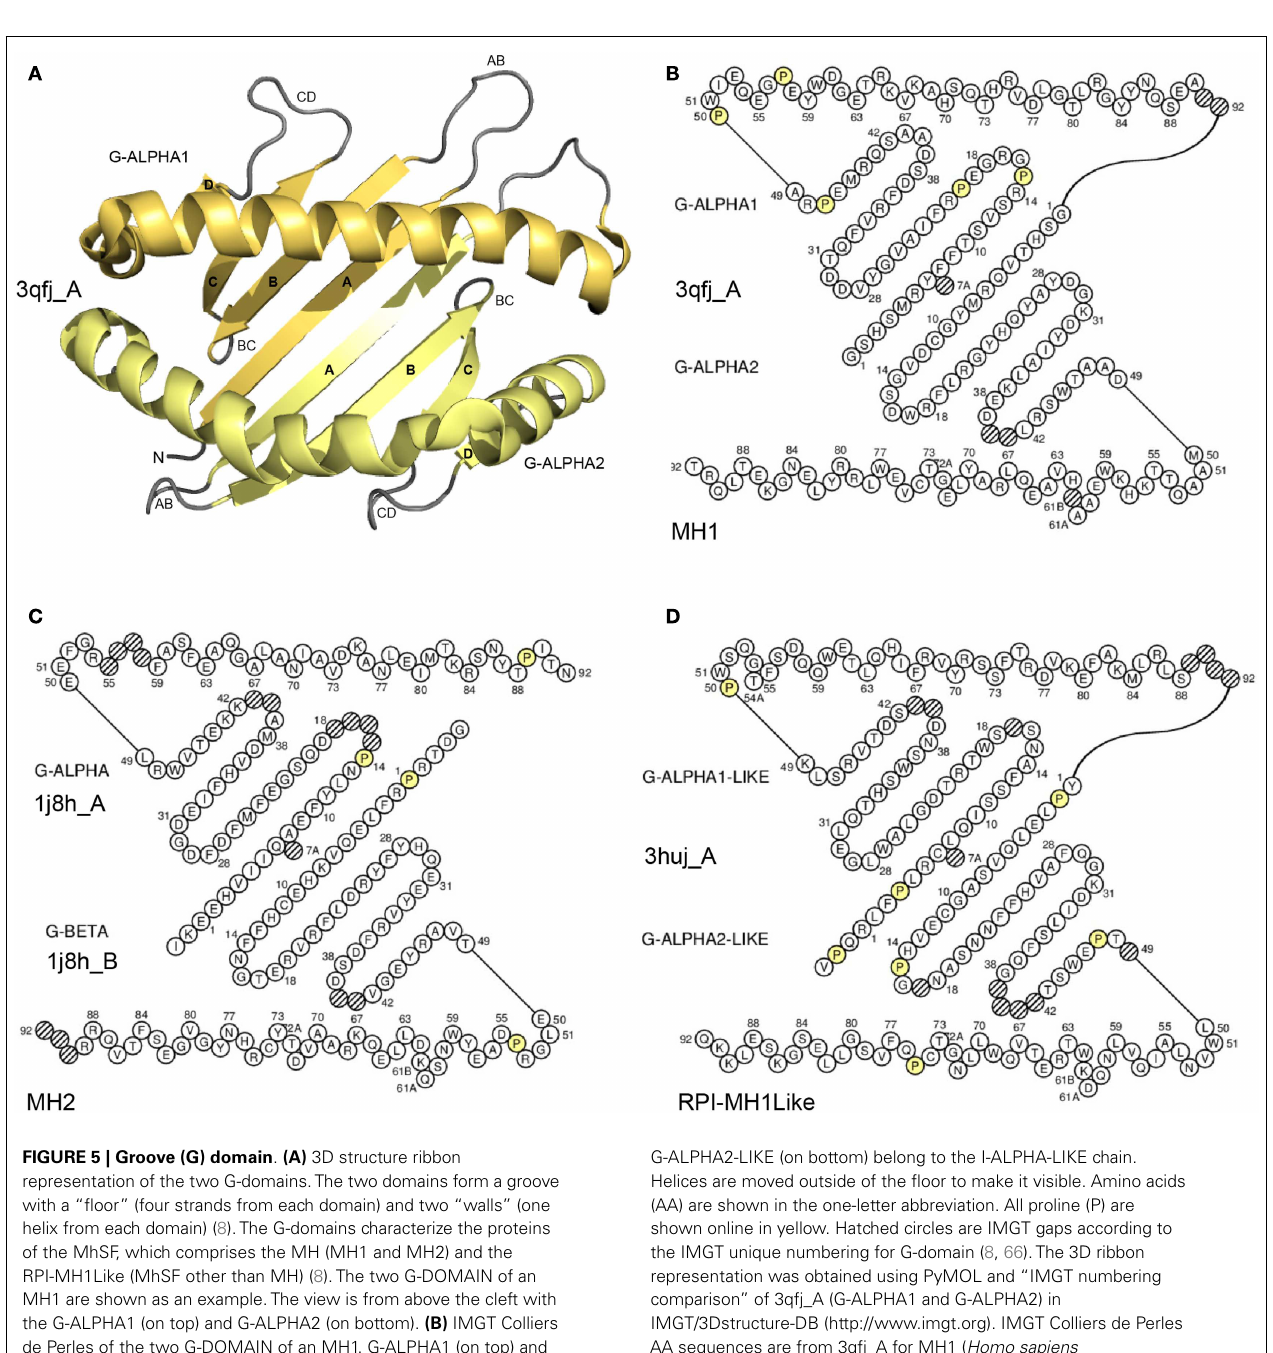
Conserved AA. Two conserved cysteines, CYS-11 (in the A- strand) and CYS-74 (in the helix) ( Table 7 ), are found in the G-ALPHA2, G-BETA, and G-ALPHA2-LIKE ( Figure 5 ), where they form a disulfide bridge fixing the helix to the